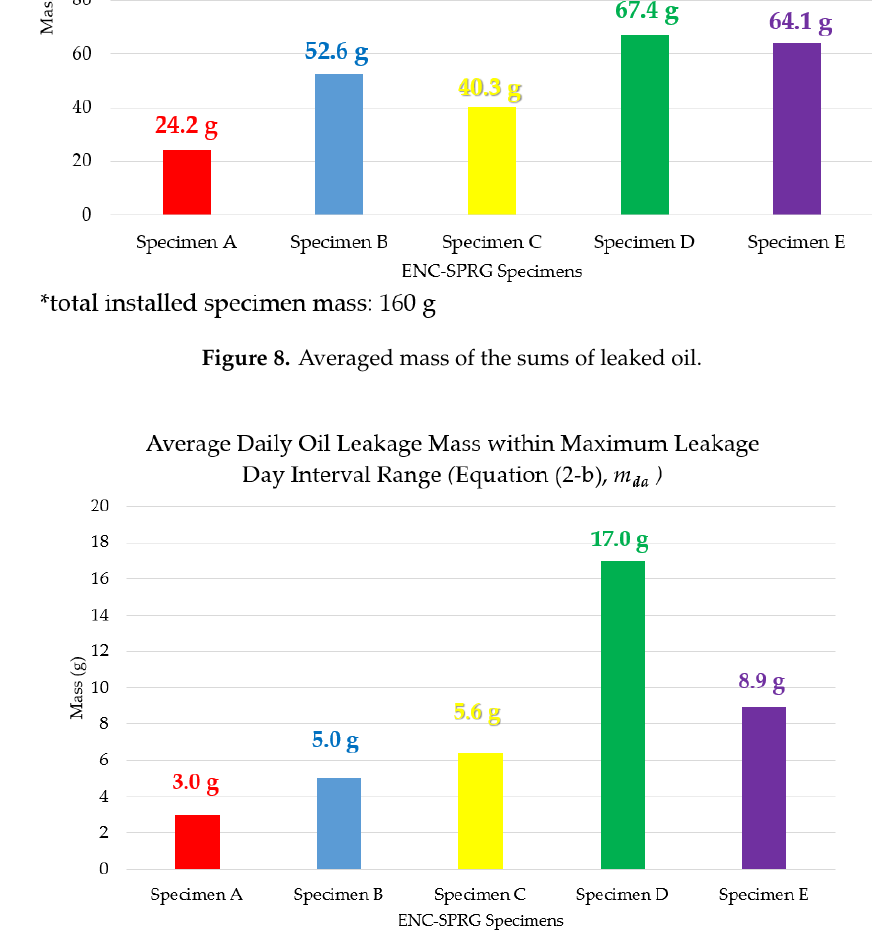
Figure 9. Average daily oil leakage mass of ENC-SPRG specimens.